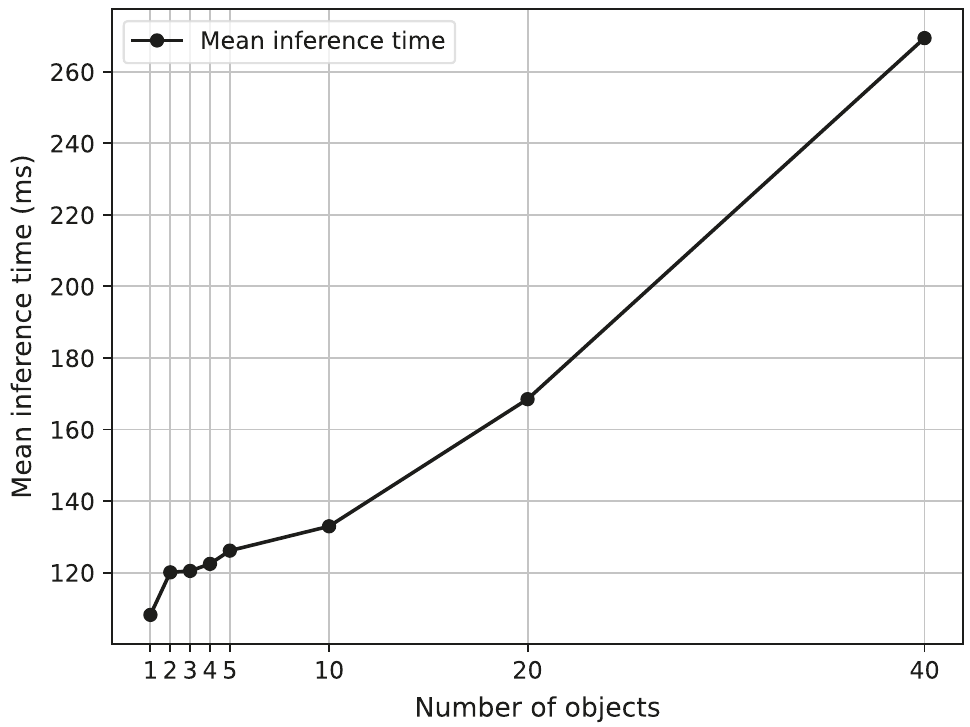
Figure 23. Mean inference time for the detection stage over number of